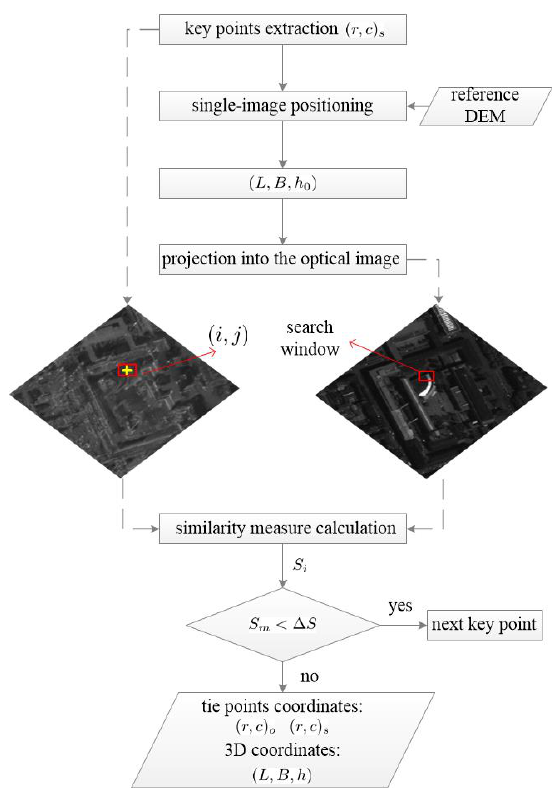
Figure 1. Procedure of the proposed tie point matching strategy. where a ground point is not existing in the SAR image at all, because of radar shadow or